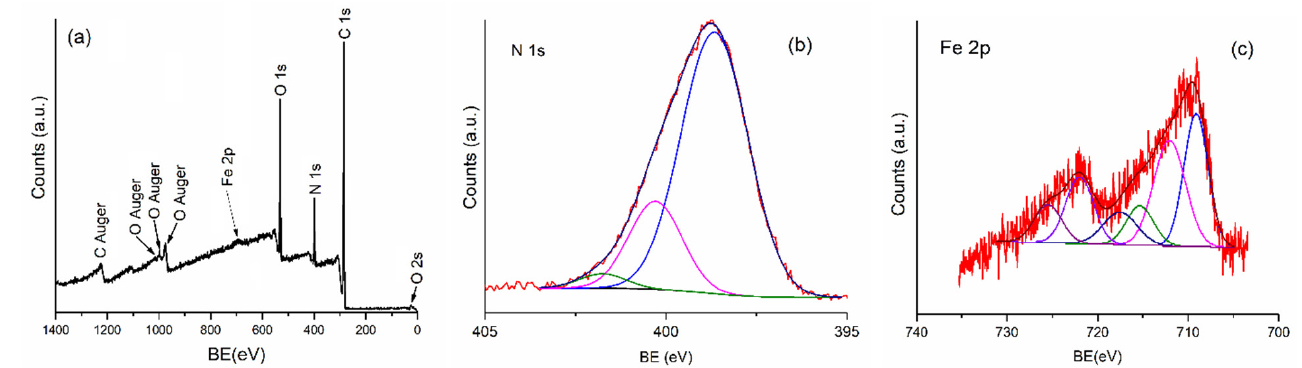
Figure 7. The general spectrum of PANI-IO ( a ), the N 1s XPS core-level spectrum of PANI-IO ( b ), and the Fe 2p high-resolution core-level XPS spectra of PANI-IO ( c ). The Fe 2p high-resolution core-level XPS spectra of PANI-IO in Figure 7 revealed the presence of a peak at 710.9 (Fe 2p3/2) and 721.98 eV (Fe 2p1/2), which were attributed to Fe 2+ . The peaks at 711.06 (Fe 2p3/2) and 724.89 eV (Fe 2p1/2) were assigned to Fe 3+ . These